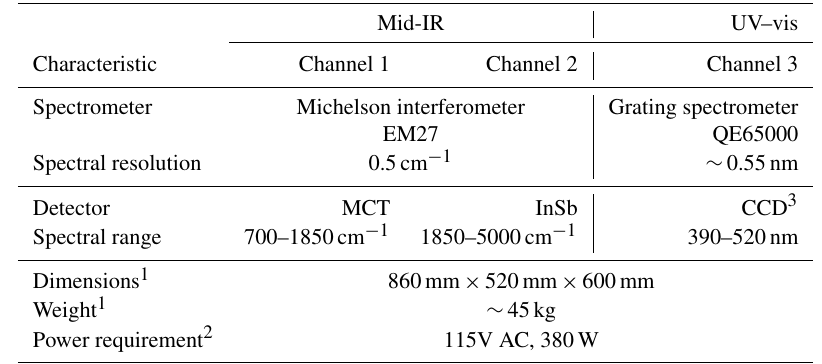
Table 1. Specifications of the CU mobile SOF instrument.